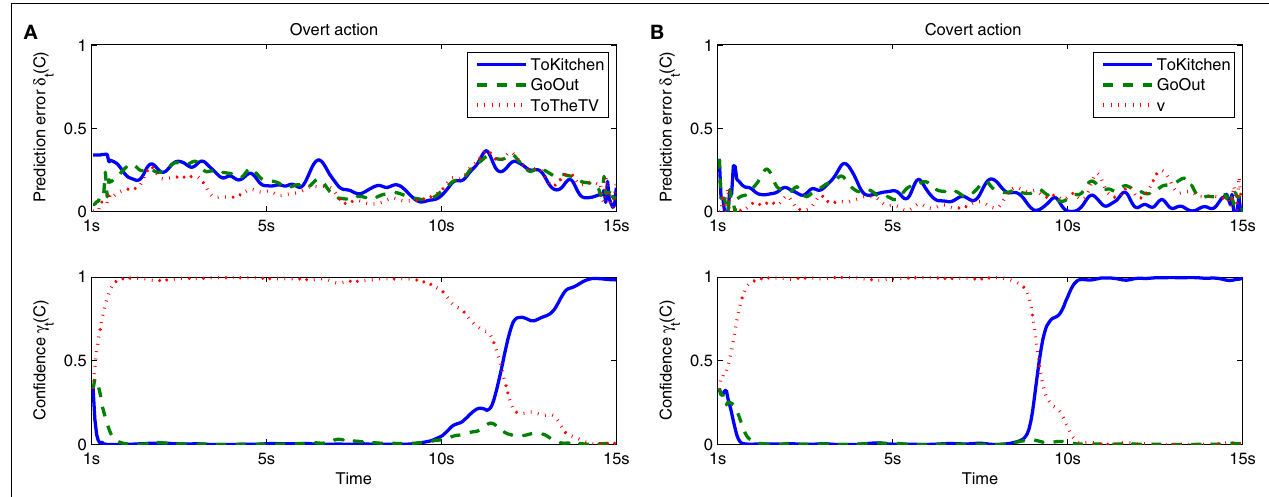
FIGURE 6 | Prediction errors and confidence levels for overt (A) and covert (B) runs from bed to kitchen, as depicted in Figure5 . Values are given for each context (c.f. Section 5). See Section 3 for definitions.